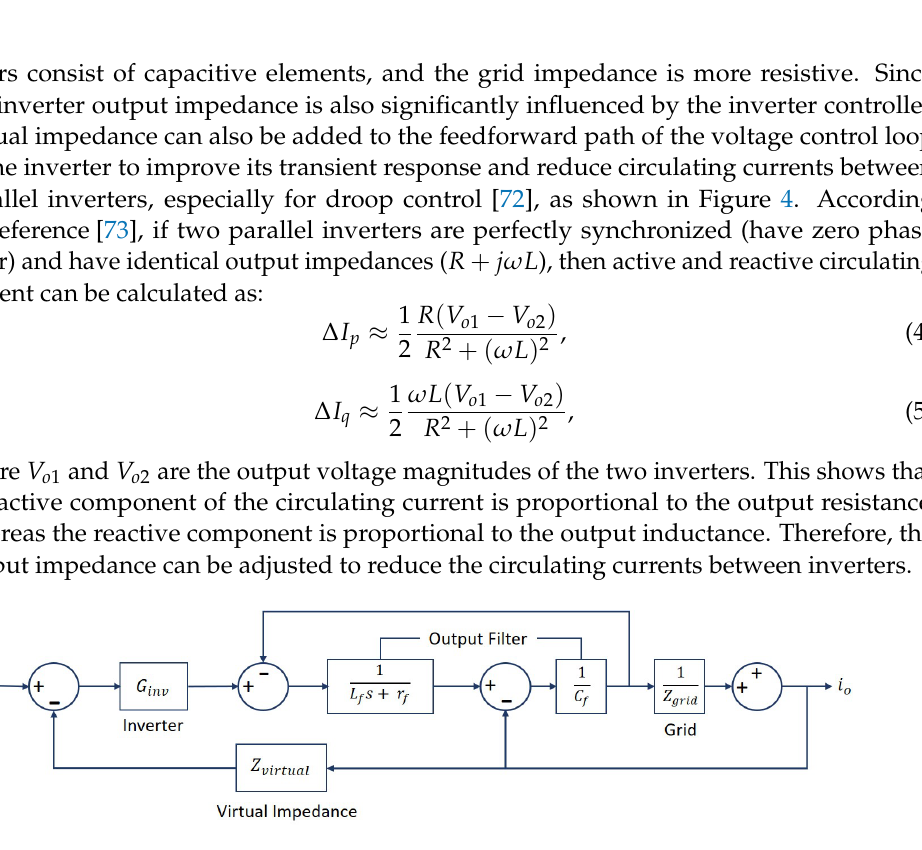
Figure 4. Block diagram of a grid-connected inverter with virtual impedance